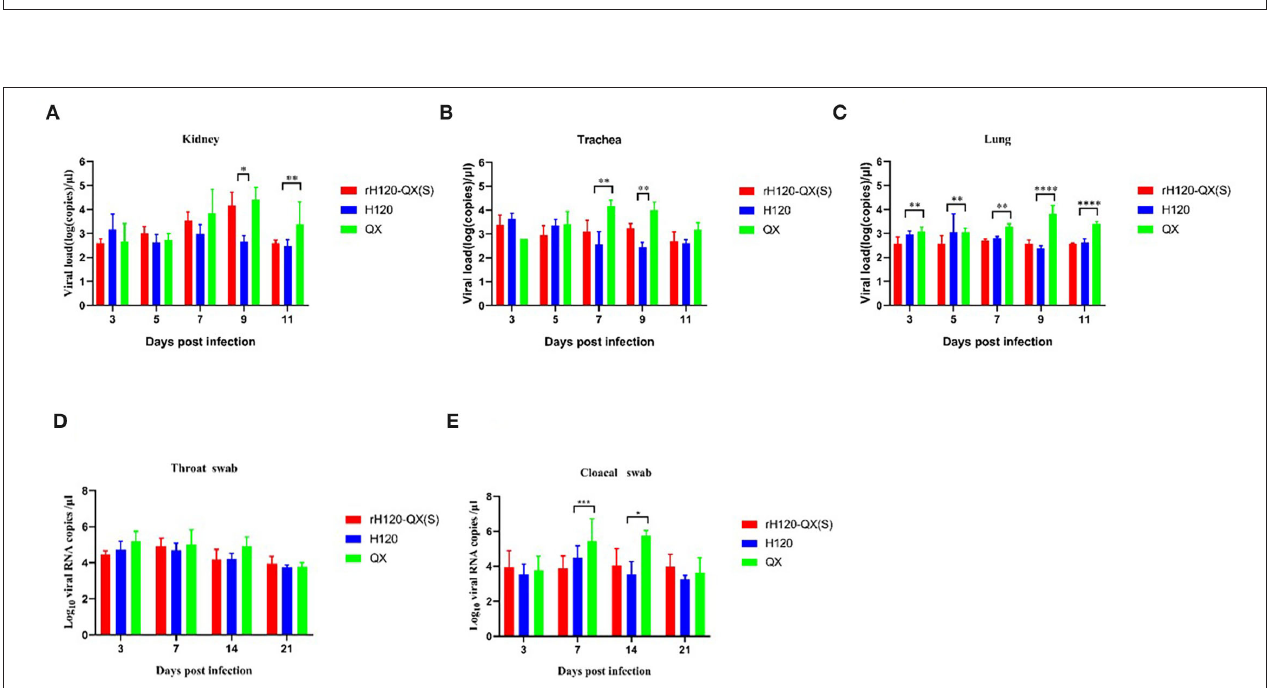
FIGURE 4 | Virus load in various tissues in SPF chickens infected with rH120-QX(S), H120, or QX. Virus load in the kidney (A) , trachea (B) , lung (C) , and was measured by RT-PCR on 3, 5, 7, 9, and 11 d.p.i. (D,E) Virus load in the throat and cloacal of the SPF chicken infected with rH120-QX(S), H120, or QX. Virus load was measured by RT-PCR on 3, 7, 14, and 21 d.p.i. * p ≤ 0.05; ** p ≤ 0.01; *** p ≤ 0.001; **** p ≤ 0.0001.